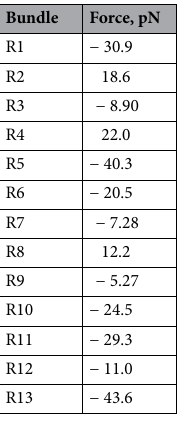
Table 1. The calculated electrostatic force values between the alpha-helices for each alpha-helix coiled-coiled sub-domain within talin’s rod domain. All alpha-helices within each sub-domain were statically positioned. Negative force values represent attractive interaction and positive force values represent repulsive interactions. Therefore, the three outliers were R2, R4 and R8 within unexpectedly repulsive